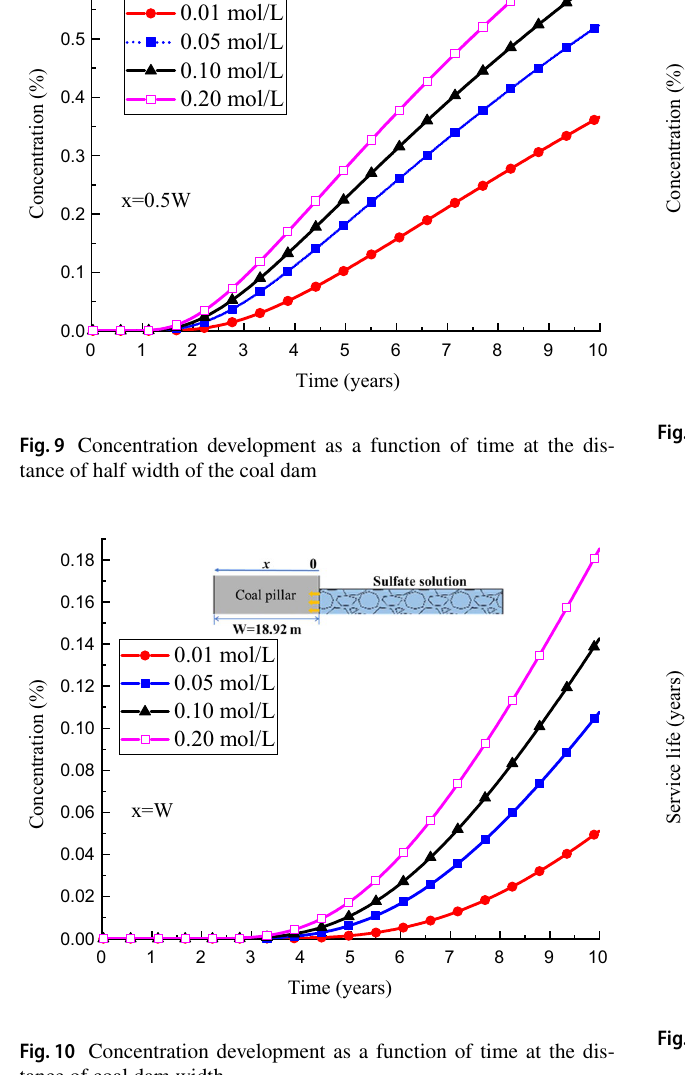
Fig. 10 Concentration development as a function of time at the dis- tance of coal dam width